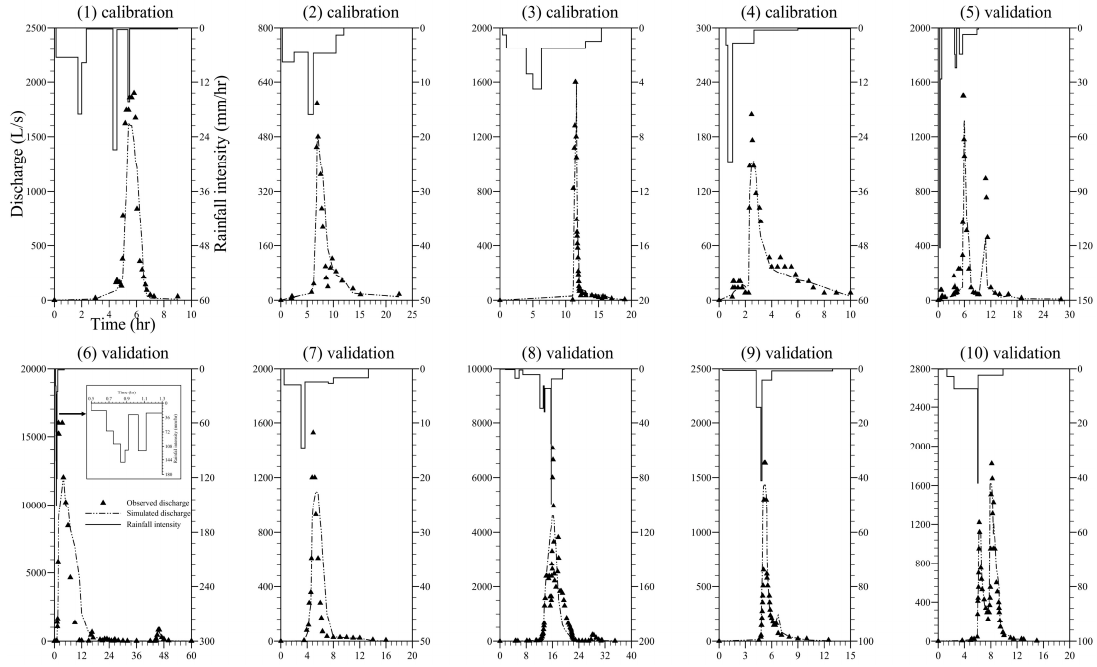
Figure 5. Observed and simulated hydrographs for the ten events in the first simulation stage. ( 1 )–( 4 ) were events for calibration, ( 6 )–( 10 ) were events for validation.